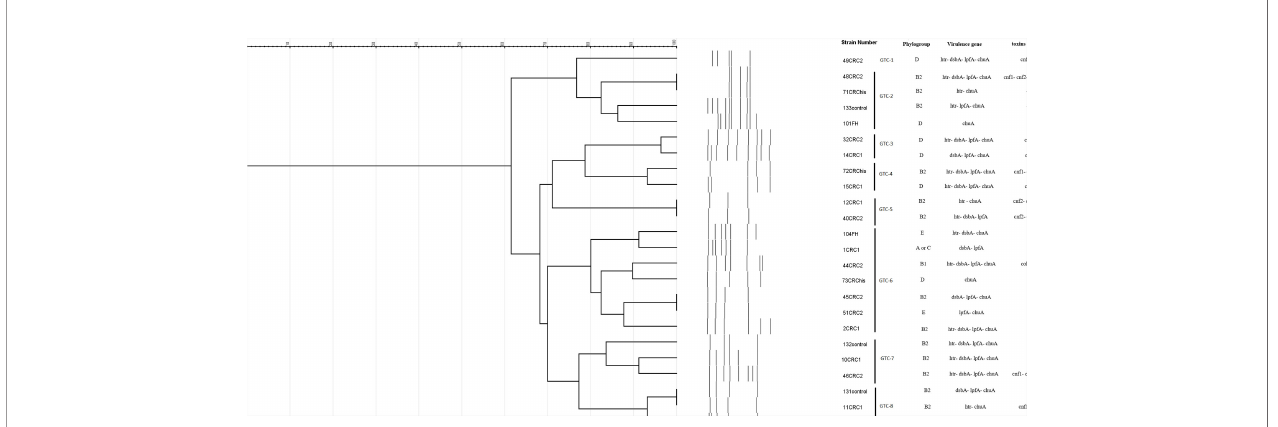
FIGURE 3 | Dendrogram showing the genetic relatedness of the 24 adherent – invasive Escherichia coli (AIEC) strains determined by repetitive element sequence- based PCR (rep-PCR) analysis. Dice similarity coef fi cient and unweighted pair group method with average linkage clustering method were used (cutoff =